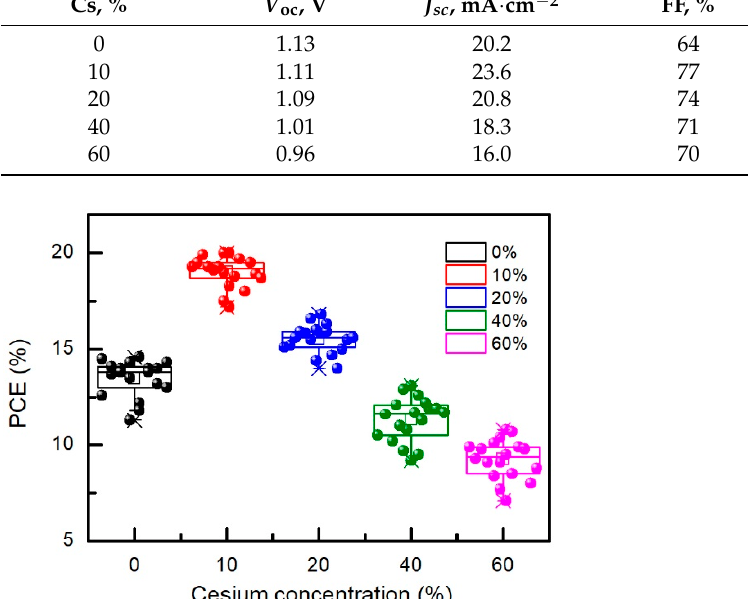
Table 3. Photovoltaic parameters of the perovskite solar cells with different cesium concentration.